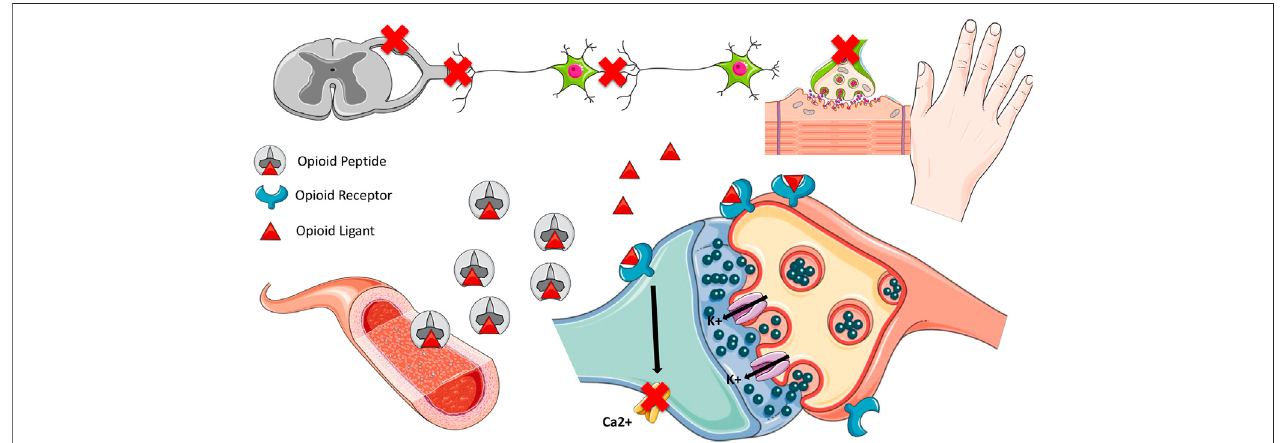
FIGURE 1 | Pharmacodynamics of opioids. Opioids inhibit the release of Glutamate and Substance P by the dorsal ganglion neuron in the spinal cord and brain through the activation of G proteins, which inhibit adenylate cyclase and regulate ion channels by binding to opioid receptors. Once the opioid binds to the receptor, potassium in fl ux and calcium channel blockage inthe synaptic cleft occurs. Three opioid receptors: mu,delta and kappa, which are metabotropic receptors and bind to G protein, are responsible for the analgesic effect. Delta and mu receptor agonist opioids have mainly analgesic action, and delta receptor agonist opioids seem to presentfewersideeffectsafteralongperiodofuse.TheKappareceptorcaninducedopaminereleaseandcontributetothedevelopmentofhallucinationanddysphoria behaviors.Opioidshaveahighvolumeofdistributionduetotheirhighliposolubility.Therefore,ashortinfusionbolus,forexample,mayhavesigni fi canteffectsonplasma concentrations (Henriksen and Willoch, 2008; Bruijnzeel, 2009; Stein and Lang,